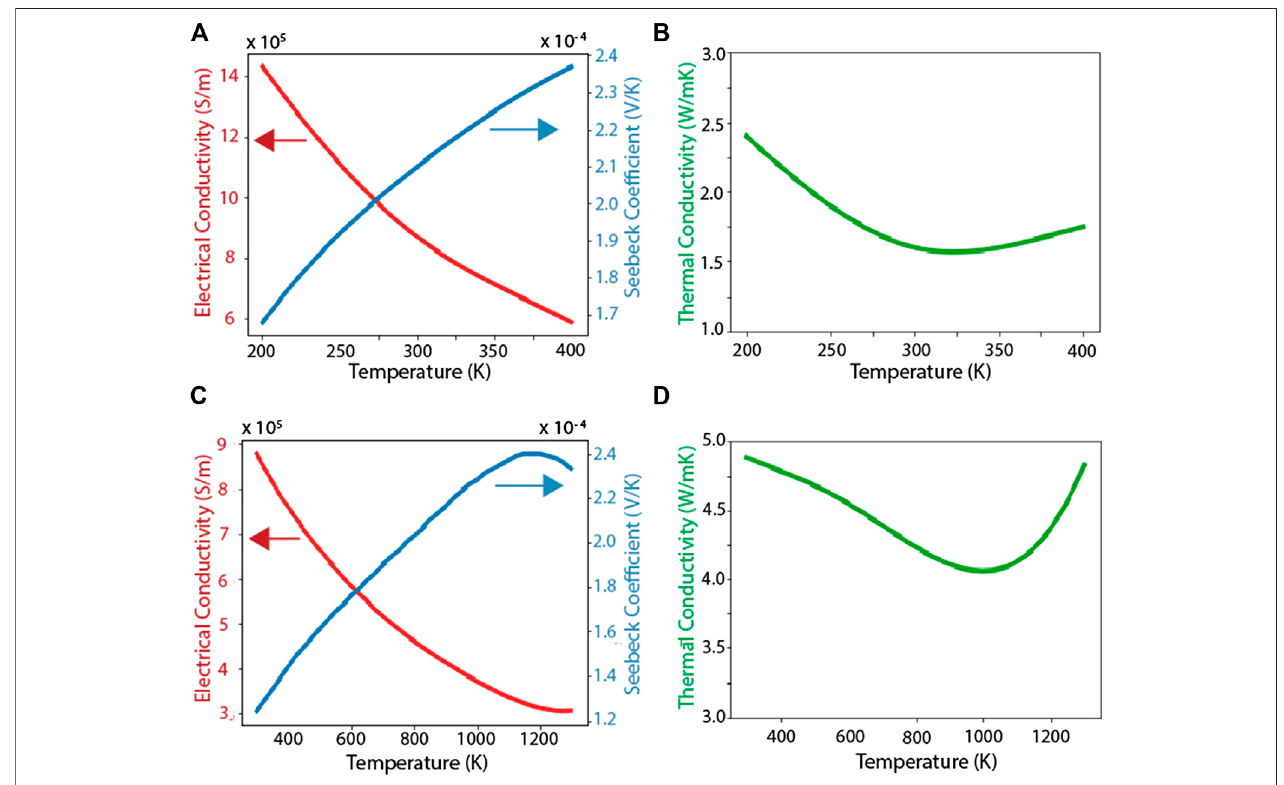
FIGURE 4 | Material properties of thermoelectric materials used in the simulations. (A) Electrical conductivity, Seebeck coef fi cient, and (B) thermal conductivity